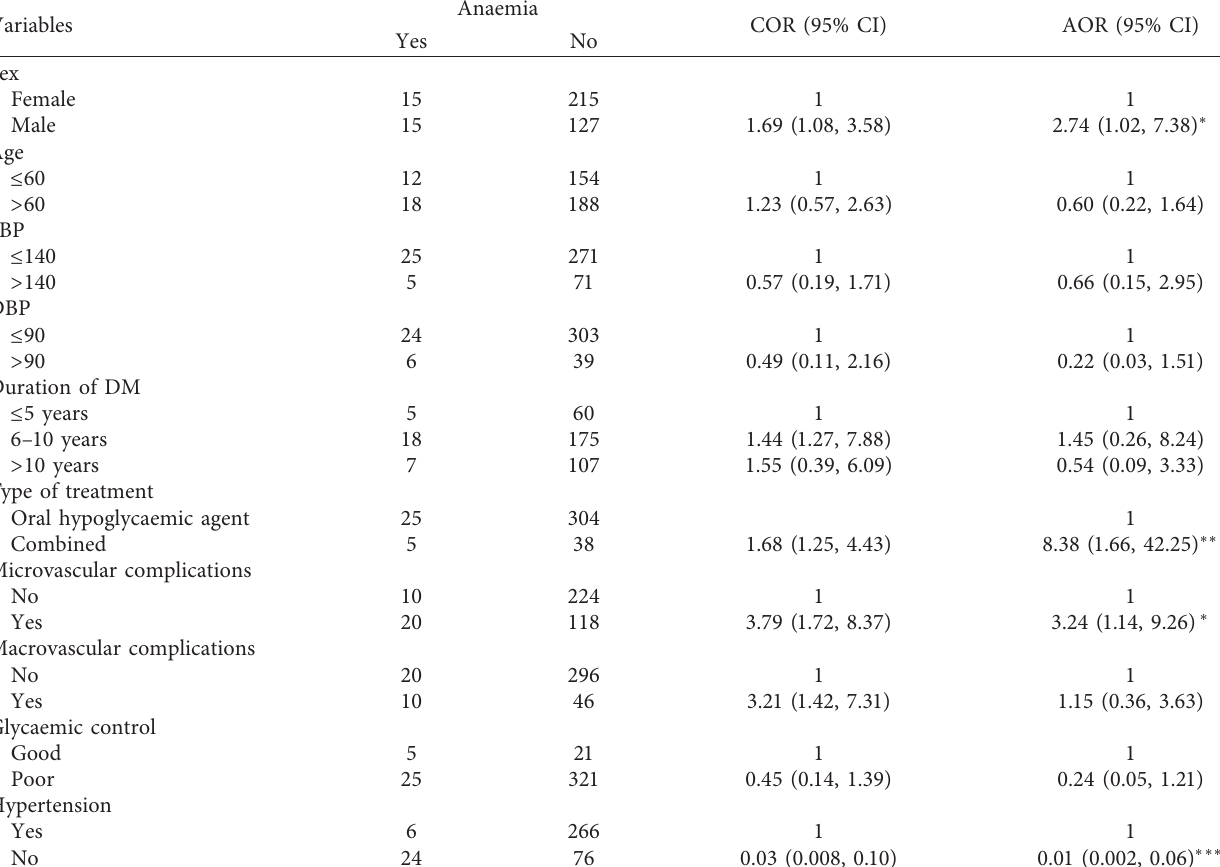
Table 2: Multivariable logistic regression of variables associated with anaemia among T2DM patients in UGCSH, Northwest Ethiopia, 2019.